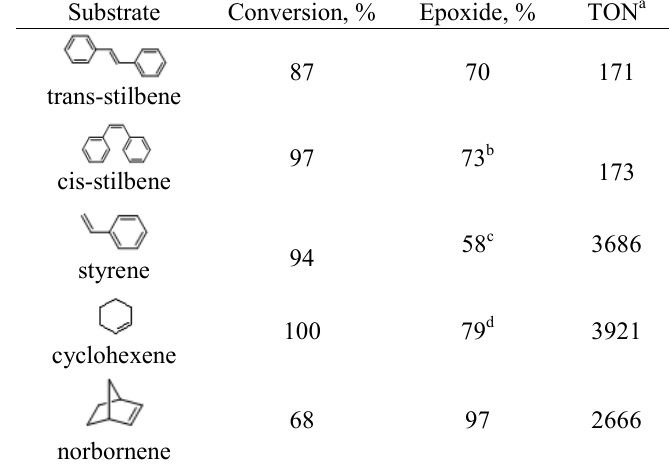
Table 4 . Epoxidation results of some olefins with molecular oxygen in the presence of Co(bipy) 22+ /Al-MCM-41 as